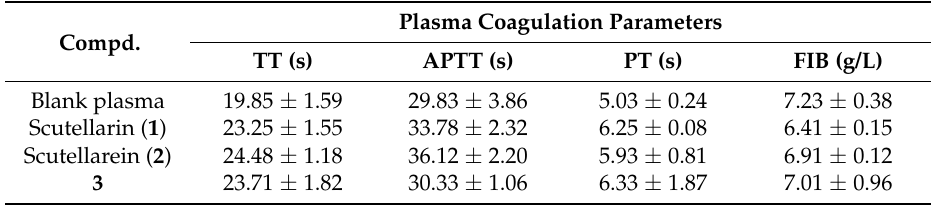
Table 2. The thrombin inhibition activity of scutellarin ( 1 ), scutellarein ( 2 ), and 3 . APTT: activated partial thromboplastin time; FIB: fibrinogen; PT: prothrombin time; TT: thrombin time. Compd.